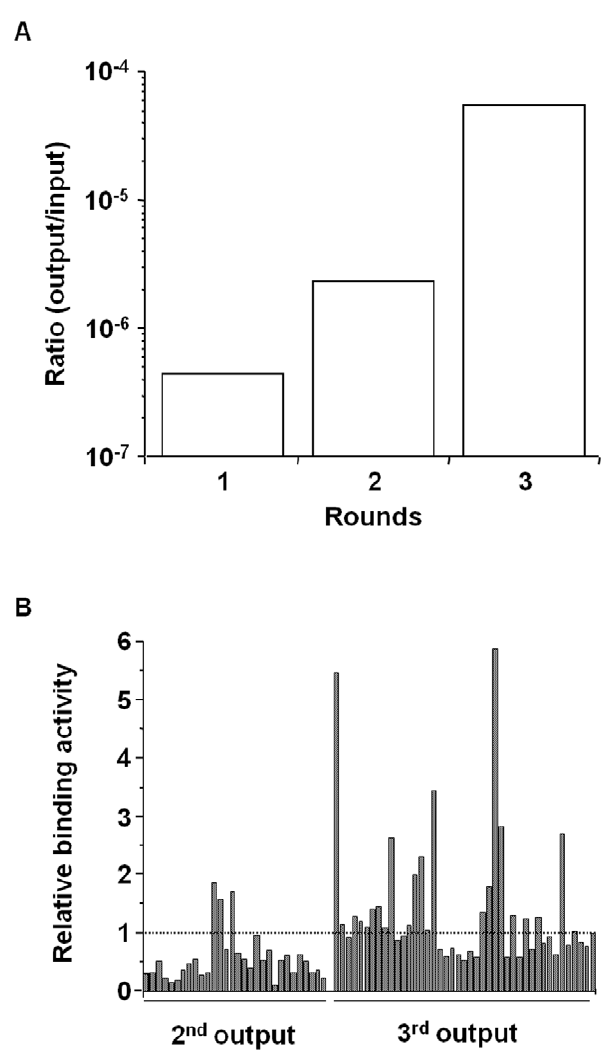
Figure 3. Screening of a novel CL4 binder. A) Enrichment of phages with affinity to CL4-BV. CL4-BVs coated on immunotubes were incubated with the C-CPE-derivative phage library at 1.6 6 10 12 CFU titer (1 st input phage). The phages bound to CL4-BV were recovered (1 st output phage). The CL4-BV-binding phages were subjected to two additional cycles of the incubation and wash step, resulting in 2 nd , 3 rd output phage. The ratio of output phage to input phage titers was calculated. B) Monoclonal analysis of C-CPE-derivative phage. CL4-BV- bound phage clones were isolated from the 2 nd and 3 rd output phages, and the interaction of the monoclonal phage with CL4-BV was examined by ELISA with anti-M13 antibody as described in Materials and methods. Data are expressed as relative binding to that of C-CPE- phage indicated by the most right column.